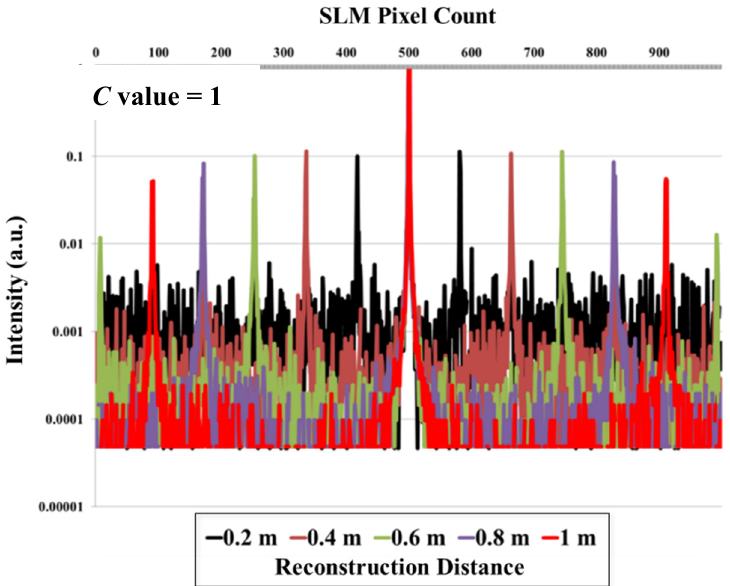
Figure 5. The intensity distribution of a single-point hologram according to the reconstruction distance (log scale).